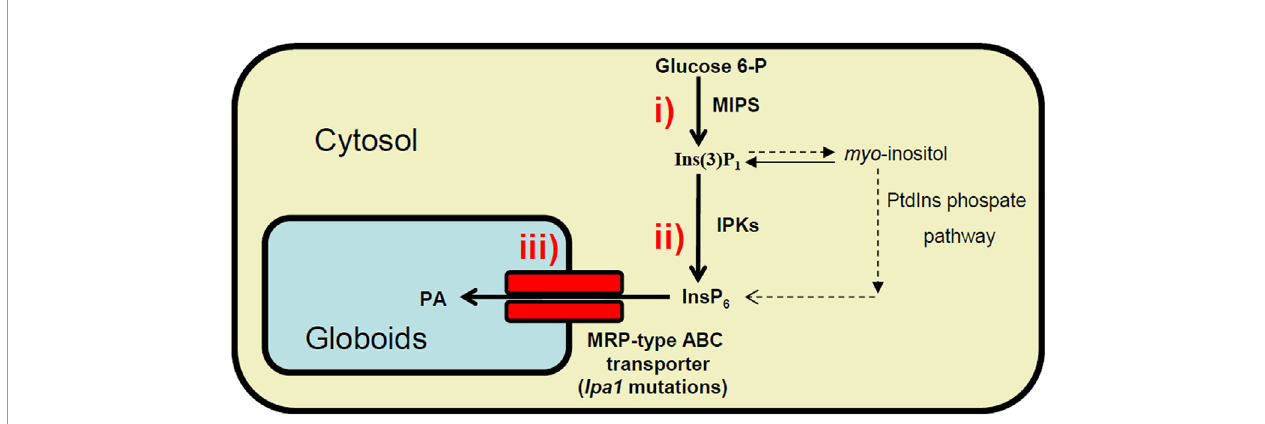
FIGURE 1 | Schematic view of the biosynthetic pathways leading to PA accumulation in globoids (storage vacuoles) in seeds. lpa mutations can be divided into three classes: i) mutations affecting the activity of myo -inositol 3-phosphate synthase (MIPS); ii) the successive phosphorylation steps of PA pathway, from Ins(3)P1 to the accumulation of PA; iii) transport by MRP transporters and storage of PA into the